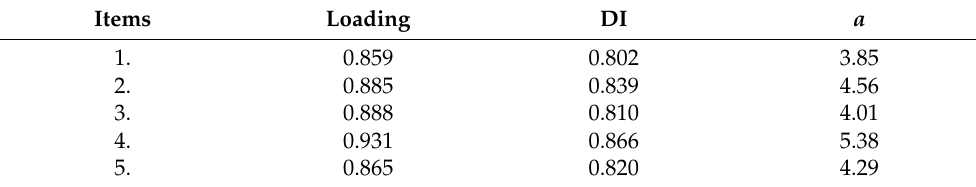
Table 3. ODSIS factor loadings, discrimination indices and discrimination parameter a